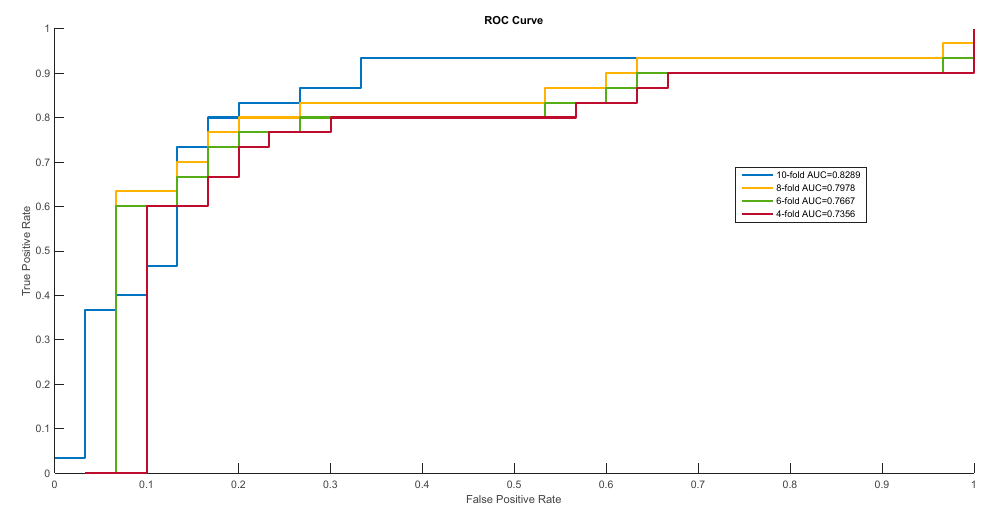
Figure 1. Receiver operating characteristic (ROC) curves of Homo sapiens .